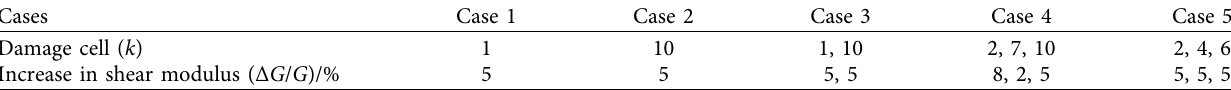
Table 2: Damage cases for the 10-cell periodic rubber–steel structure.